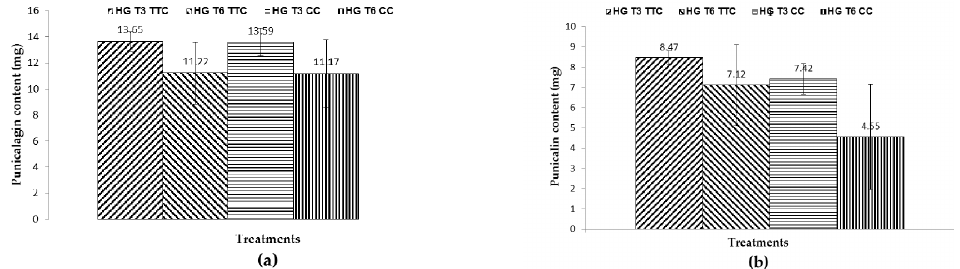
Figure 9. HPLC chromatographs of Punica granatum peel ethanolic extract hydrogel-based formulation (PGHF), showing retention times for punicalin (4.203 min) and punicalagin (5.987 min). Chromatography was run on a Shimadzu LC-20AT HPLC with SPD-M20A PDA detection. Separations were carried out on a Dr. Maisch GmbH C18 column (5 μ m, 250 mm × 4.6 mm), 25 °C, with a mobile phase of 0.1% ( v / v ) aqueous solution of phosphoric acid and acetonitrile (80:20). The mobile phase flow rate was 1 mL/min with 10 min run time. The standards were detected using a wavelength of 254 nm. Sample injection volume was 10 μ L.